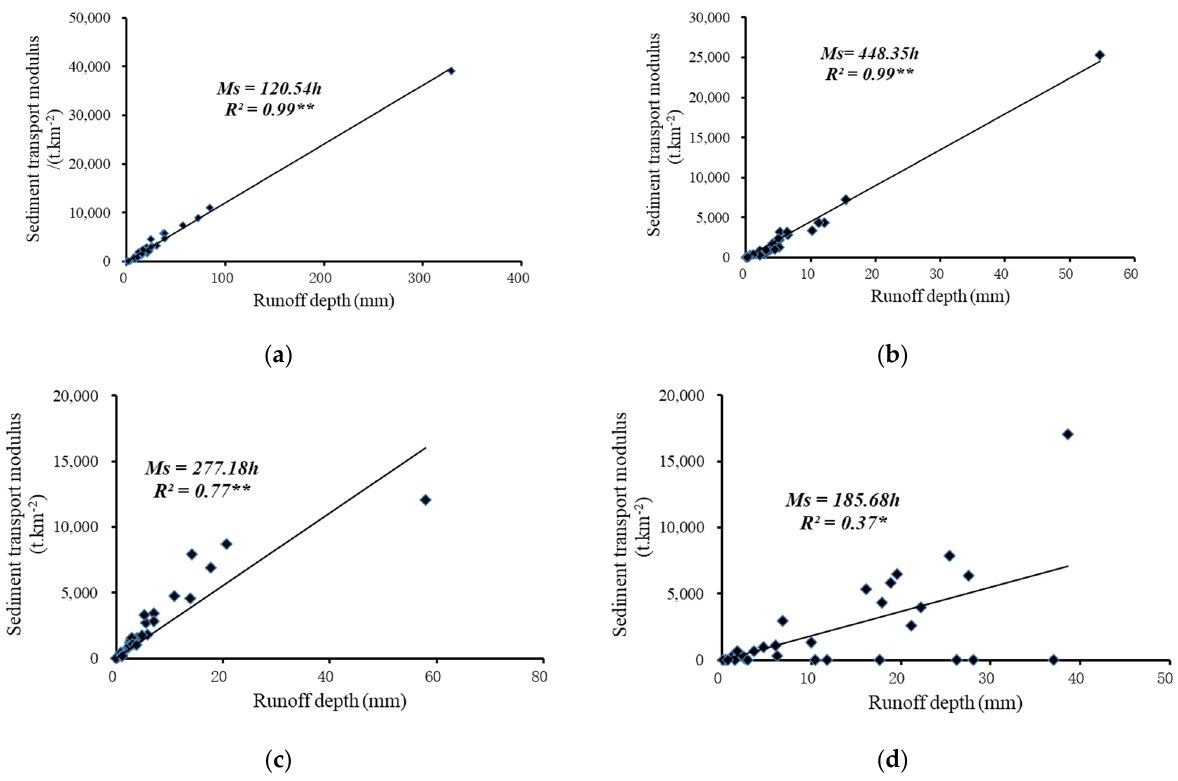
Figure 3. Relationships between runoff depth and sediment transport modulus on flood event scale. ( a ) Peijiamao watershed; ( b ) Qiaogou gully; ( c ) first branch of Qiaogou gully (subgully); ( d ) whole slope. Note: ** significance at the 0.01 level; * significance at the 0.05 level; n = 31. Further, the lower determination coefficient was only 0.37 for the runoff plot of the whole slope, which indicated that on the timescale of flood event, the variation of the